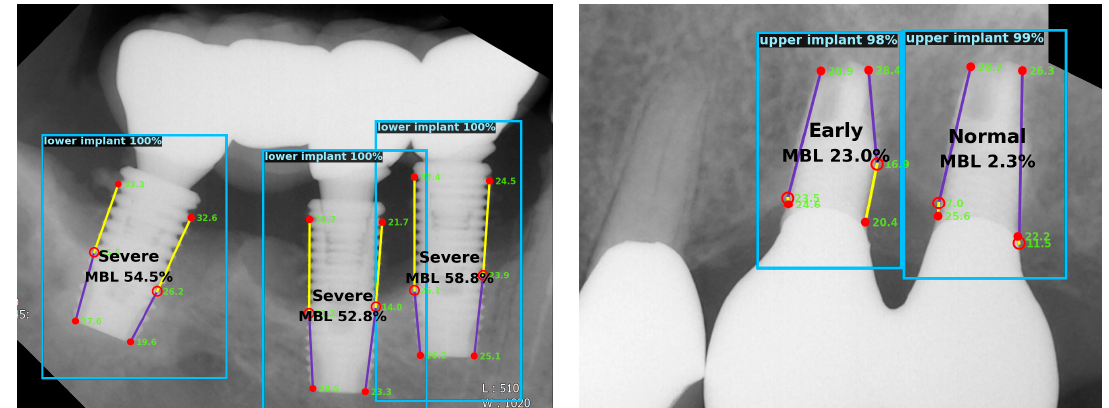
Figure 5. Examples of the predicted results. Each implant is detected with a bounding box and predicted keypoints are shown within the box. Radiographic bone loss ratio is calculated based on the keypoint locations. Confidence scores of the implant and keypoint detection are also shown.